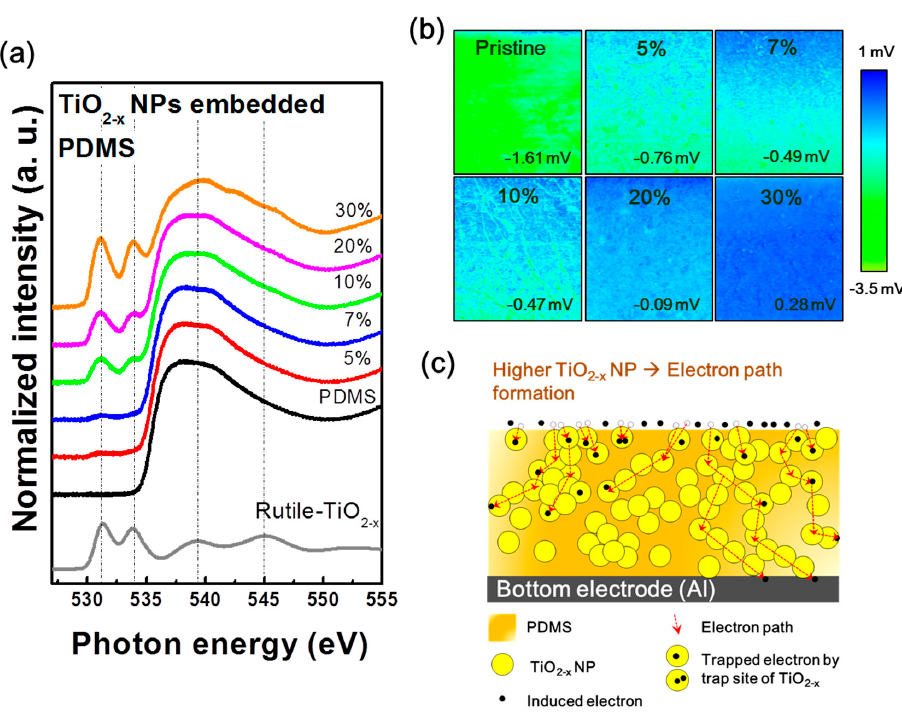
Figure 4. ( a ) O-K edge X-ray absorption spectroscopy (XAS) spectra and ( b ) Kelvin probe force microscopy (KPFM) images of PDMS layers as a function of the TiO 2 − x NPs embedded weight ratios; ( c ) Schematic of the electron leakage mechanism according to electron path formation.